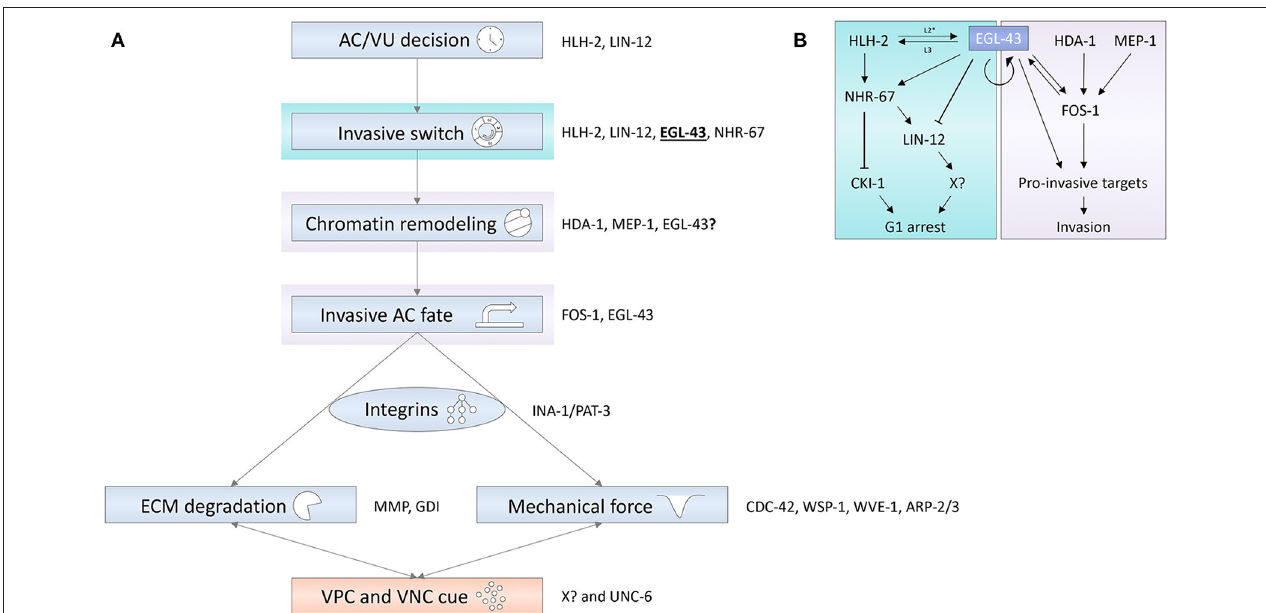
FIGURE 2 | (A) Different regulatory layers are integrated to control AC invasion. Blue shaded boxes depict cell-autonomous processes in the AC; the red shaded box represents paracrine signaling processes mediated by the VPCs and the ventral nerve cord (VNC). Some of the genes encoding factors important for the depicted processes are shown on the right of the rectangles. (B) The EVI1 homolog EGL-43 is a central node in a transcription factor network coordinating the different signaling layers that induce G1 cell cycle arrest and promote pro-invasive gene expression. Arrows refer to activating and T-bars to inhibitory